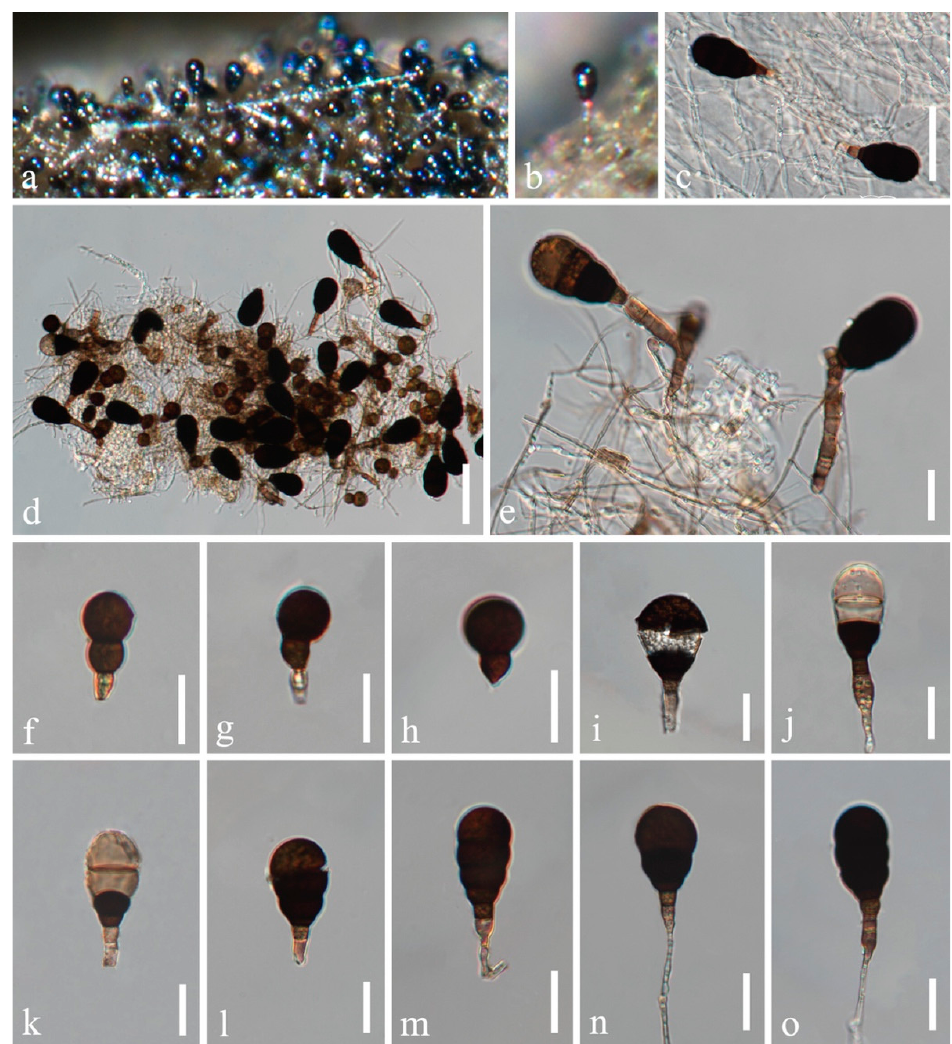
Figure 4. Reproduced asexual morph of Mucispora aquatica (CGMCC 3.20882, ex-holotype) on PDA medium. ( a , b ) Colonies on PDA. ( c − e ) Hyphae and conidiophores with conidia. ( f − o ) Conidioge- nous cells and conidia. Scale bars: ( c ) = 40 μ m, ( d ) = 50 μ m, ( e – o ) = 20 μ